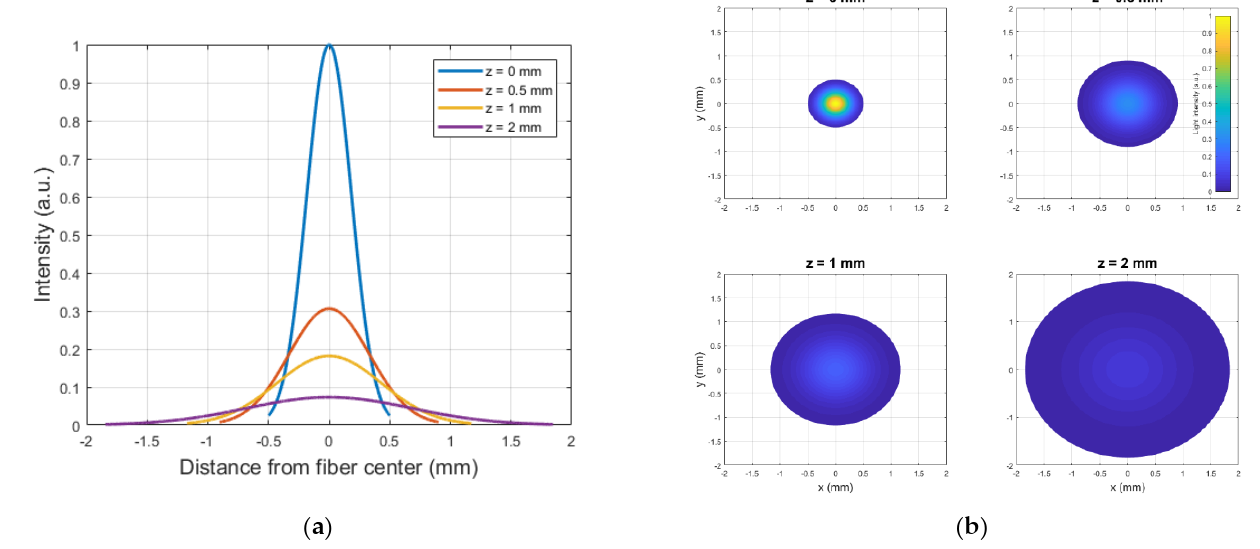
Figure 7. ( a ) Irradiance profile I (in a.u.) at a distance z from the fiber exit, considering conical beam divergence. ( b ) Irradiance profile (in a.u.) and beam with at a distance z from the fiber exit.